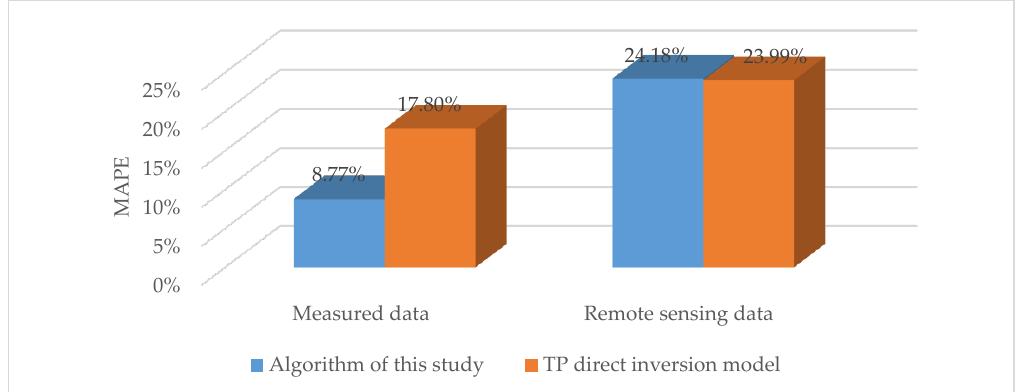
Figure 17. MAPE analysis of the TP retrieval results.